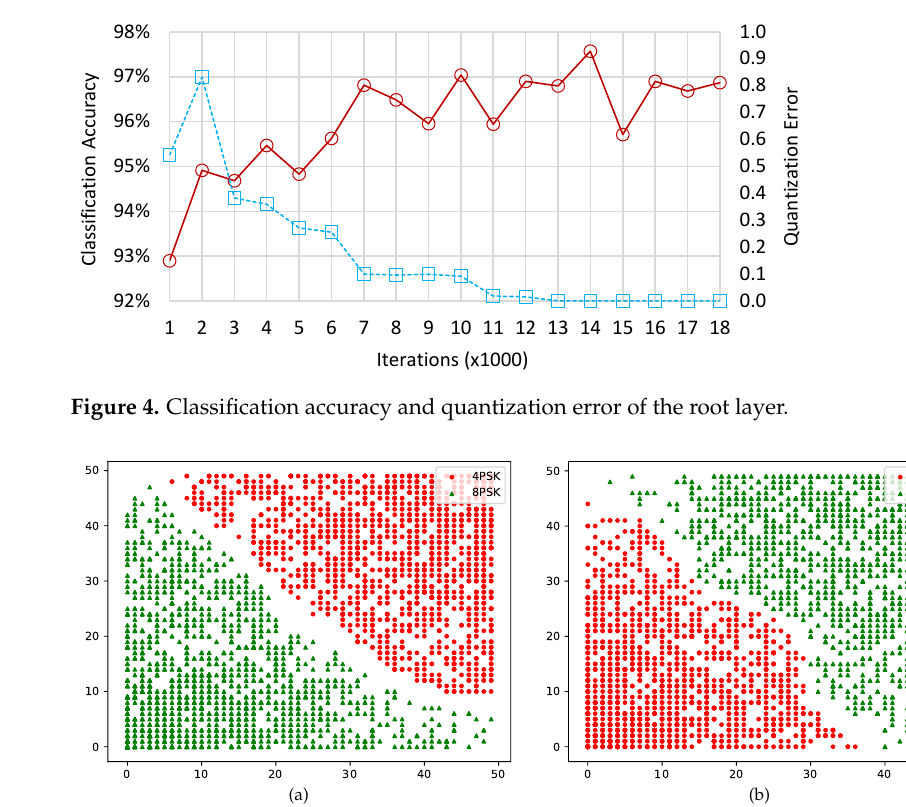
Figure 5. Clustering results of the leaf layers for MPSK and MQAM without discrete transformation.